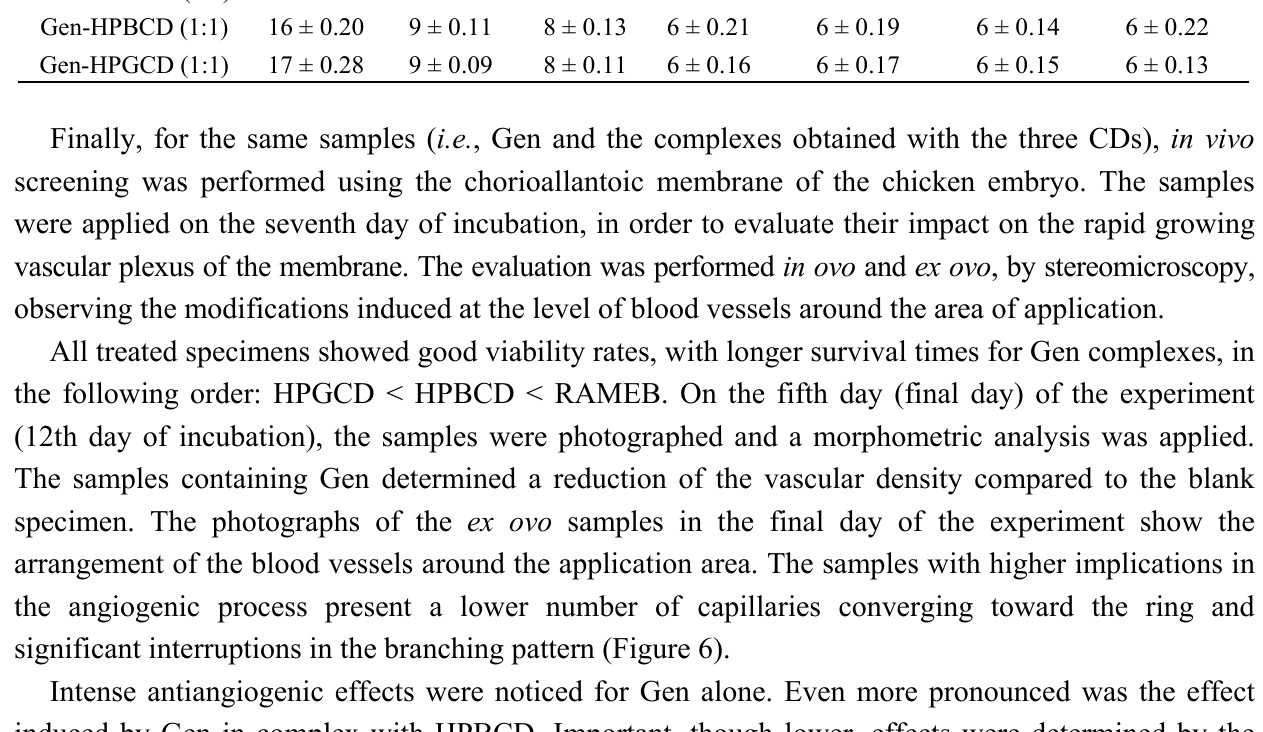
Table 4. Zone of inhibition (mm) for genistein and the tested complexes on the mentioned bacterial strains. Zone of inhibition (mm). Results are presented as mean values ± SD Compound B. S. E. E. S. S. P. subtilis aureus faecalis coli typhimurium sonnei aeruginosa Gen 15 ± 0.46 9 ± 0.12 7 ± 0.23 6 ± 0.23 6 ± 0.15 6 ± 0.23 6 ±